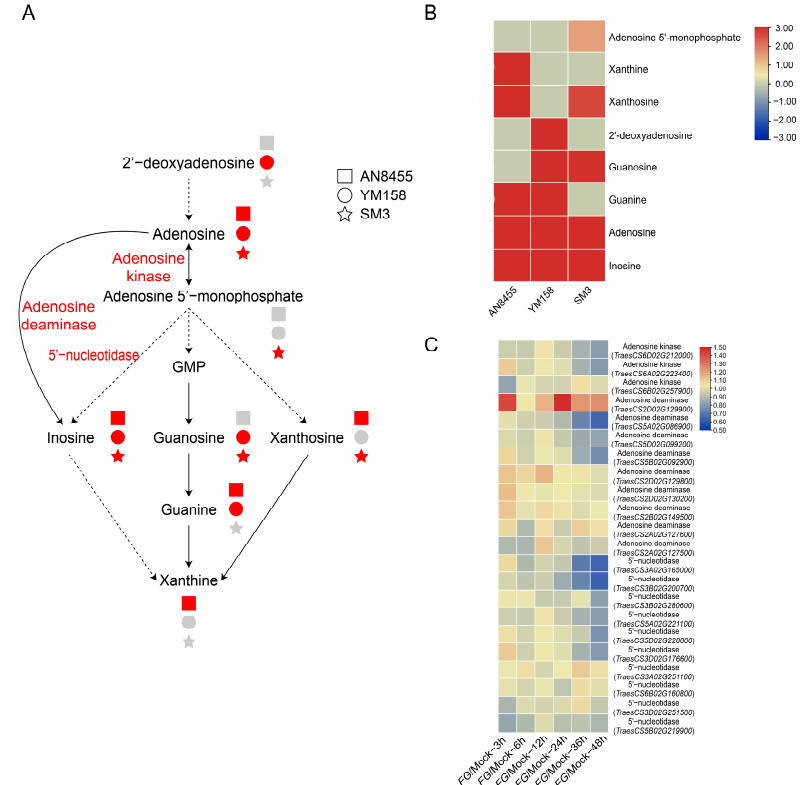
Figure 4. Metabolites that participated in nucleotide metabolism. ( A ) Schematic diagram of catabolic processes. The squares, circles, and stars represent AN8455, YM158, and SM3, respectively. Red, green, and gray shapes represent upregulated expression, no obvious change, and downregulated expression, respectively. ( B ) Radio value ( Fg vs. Mock) of metabolites involved in catabolic processes. ( C ) Gene expression heatmap of enzymes involved in nucleotide metabolism, sourcing from WheatGene (http://wheatgene.agrinome.org/ (accessed on 9 July 2022)).